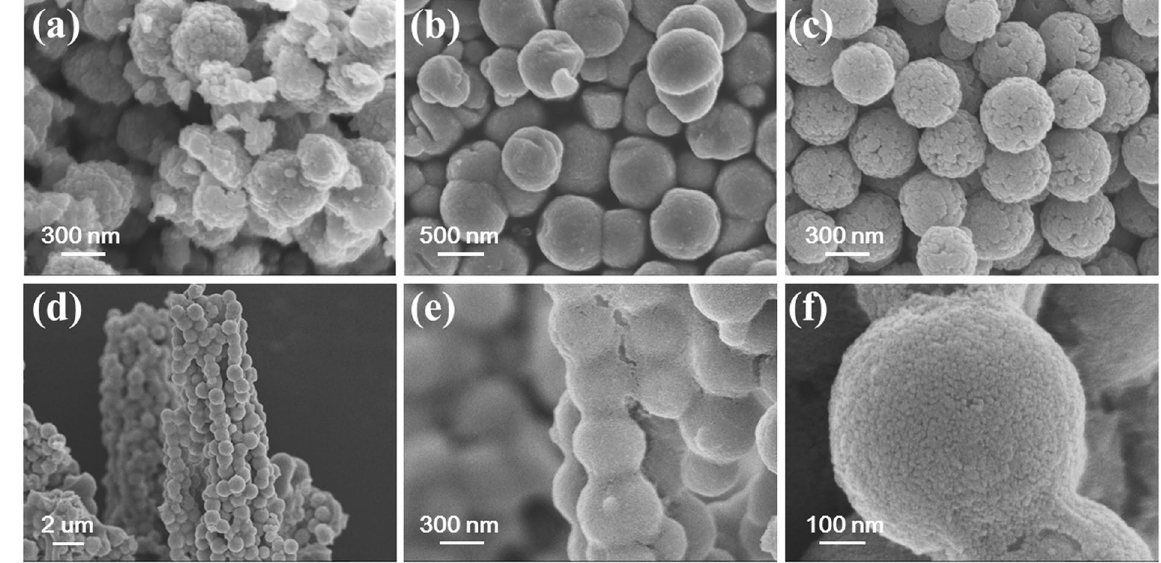
Figure 3. Typical SEM images of Fe 3 O 4 microspheres synthesized with different surfactants: ( a ) ED, ( b ) PEG, ( c ) NaPAA, and ( d )–( f ) γ -Fe 2 O 3 @SiO 2 @TiO 2 corn-like heterostructures under different magnifications.